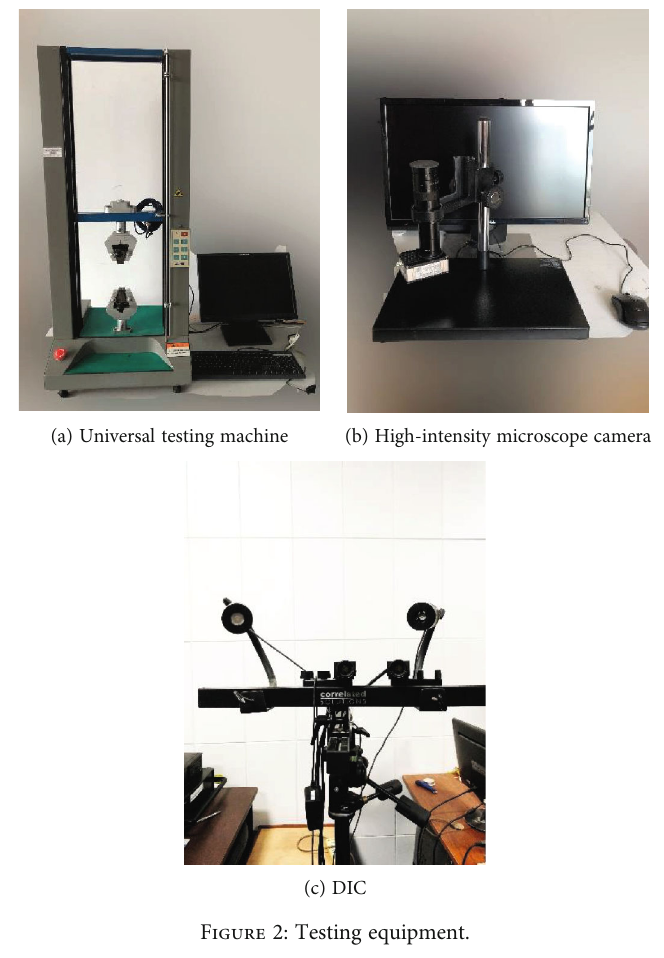
Figure 2: Testing equipment.